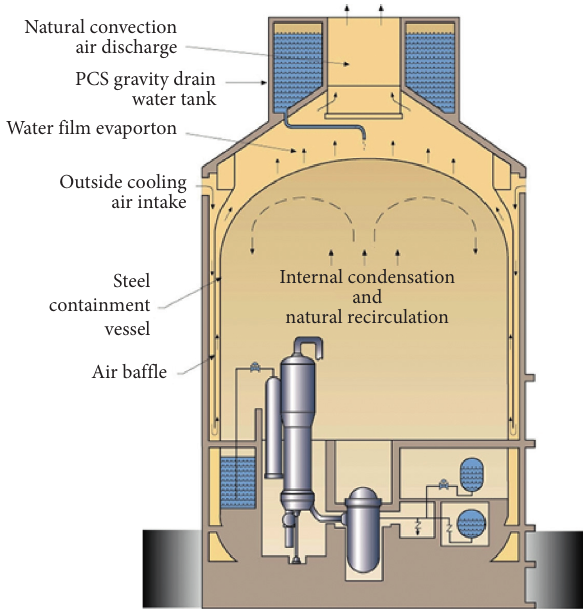
Figure 1: PCS of nuclear island